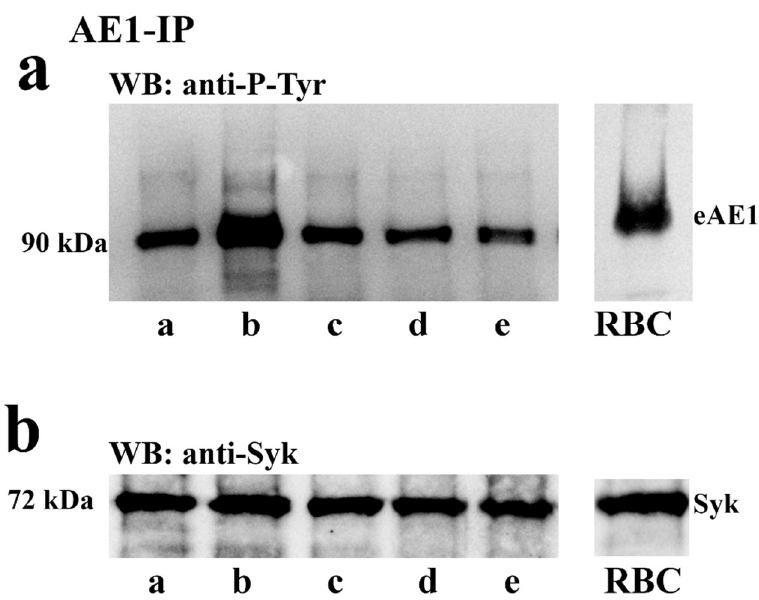
Figure 4. Sperm cells were either immediately processed (T0, lane a) or incubated for 120 min in the absence (C, lane b) or presence of + 5 µ M I-172 (C + 5I, lane c), 100 µ M DIDS C + DIDS, (lane d) or both (C ++ , lane e). Samples were extracted and immunoprecipitated with anti AE1 antibody and immunoblotted with anti-P-Tyr (panel ( a )) or anti-Syk (panel ( b )) antibodies. The RBC lane shows the anti-P-Tyr staining of erythrocyte membrane. The figure is representative of 6 separate experiments.